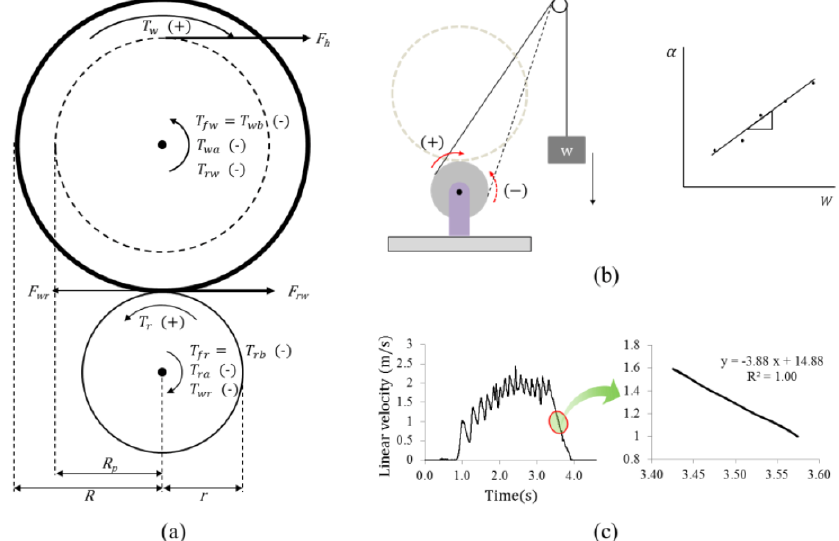
Figure 2. Two-dimensional model for calculation of the wheel torque and the resistive